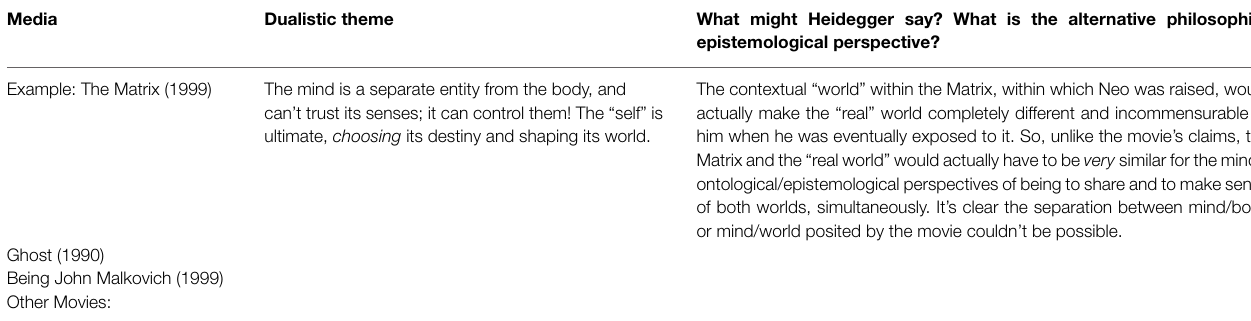
TABLE 1 | A classroom exercise to discuss and critique dualistic themes in the